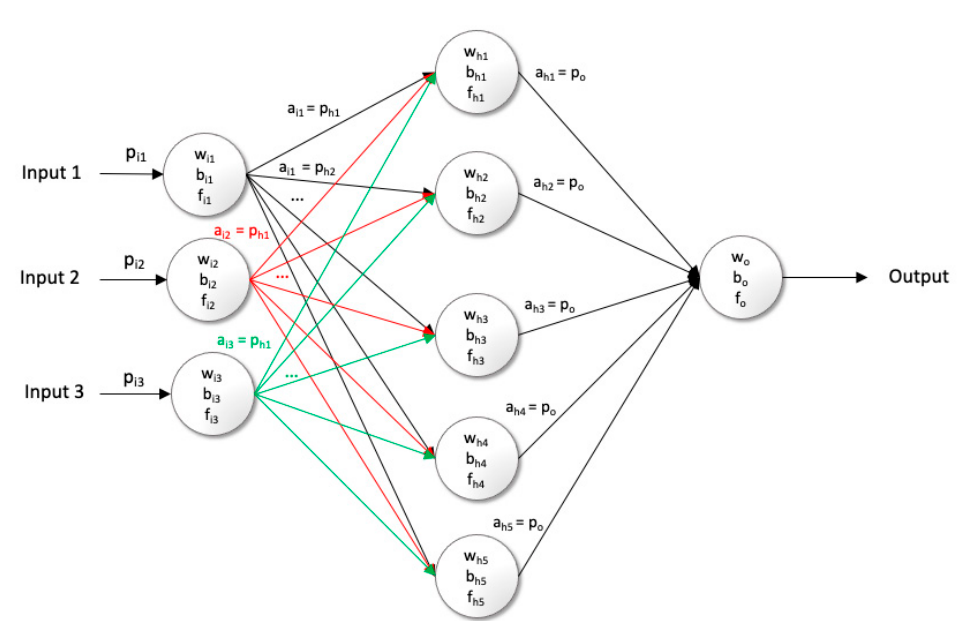
Figure 2. Example of the artificial neural network (ANN) structure with 3 neurons in the input layer, 5 hidden neurons in 1 hidden layer, and 1 output layer and the connectivity between neurons.